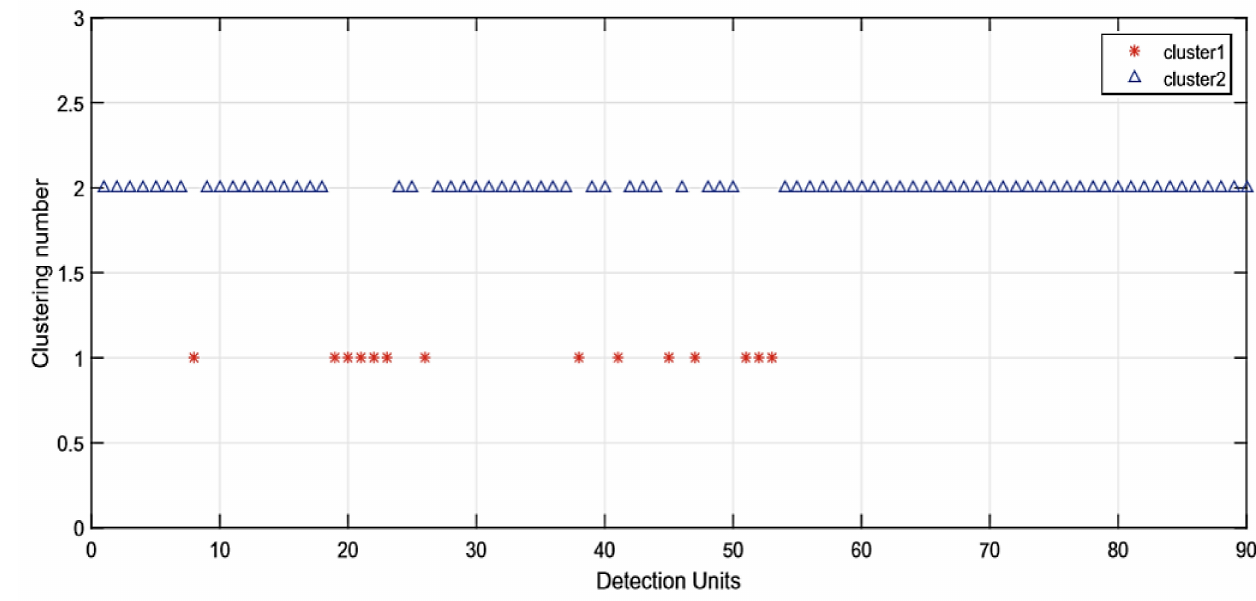
Figure 9. Cluster results of the WIDE dataset.